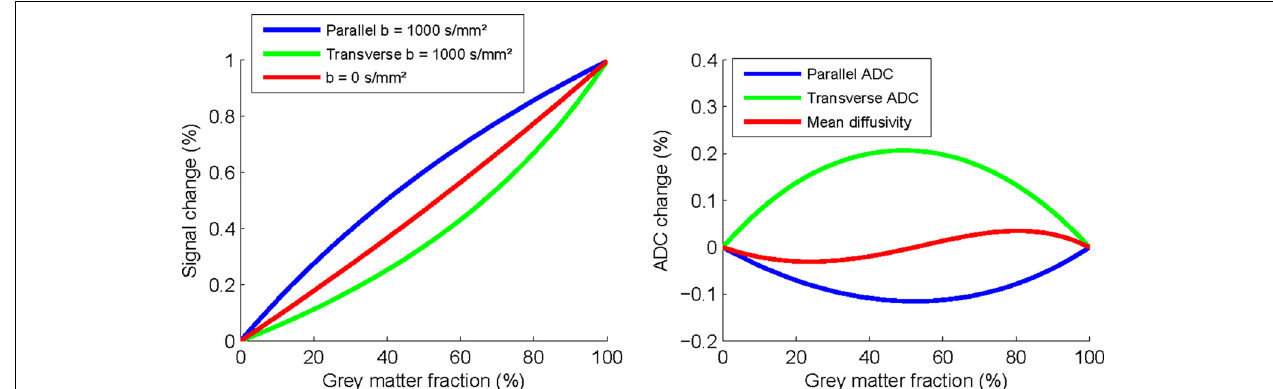
FIGURE 1 | Simulated changes in parallel and transverse diffusivity signal and ADC as a function of percentage partial-volume with gray matter.